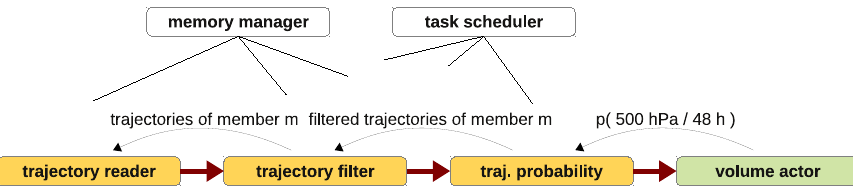
Figure 4. Sample Met.3D data processing pipeline to visualize p( WCB ) , depicted analogous to Fig. 10 in Part 1. Different pipeline modules (yellow) are responsible for reading and selecting trajectories, and for computing the p( WCB ) field. In the example, a volume actor (green; for details see Part 1, Sect. 3) visualizes the resulting p( WCB ) data. A request for the probability of occurrence of trajectories, emitted by the volume actor, triggers further requests up the pipeline. Intermediate results are cached by the memory manger, connected to each pipeline module (indicated by the black lines). Pipeline execution can be parallel and is controlled by a task scheduler, also connected to all pipeline modules (for details see Part 1, Sect.